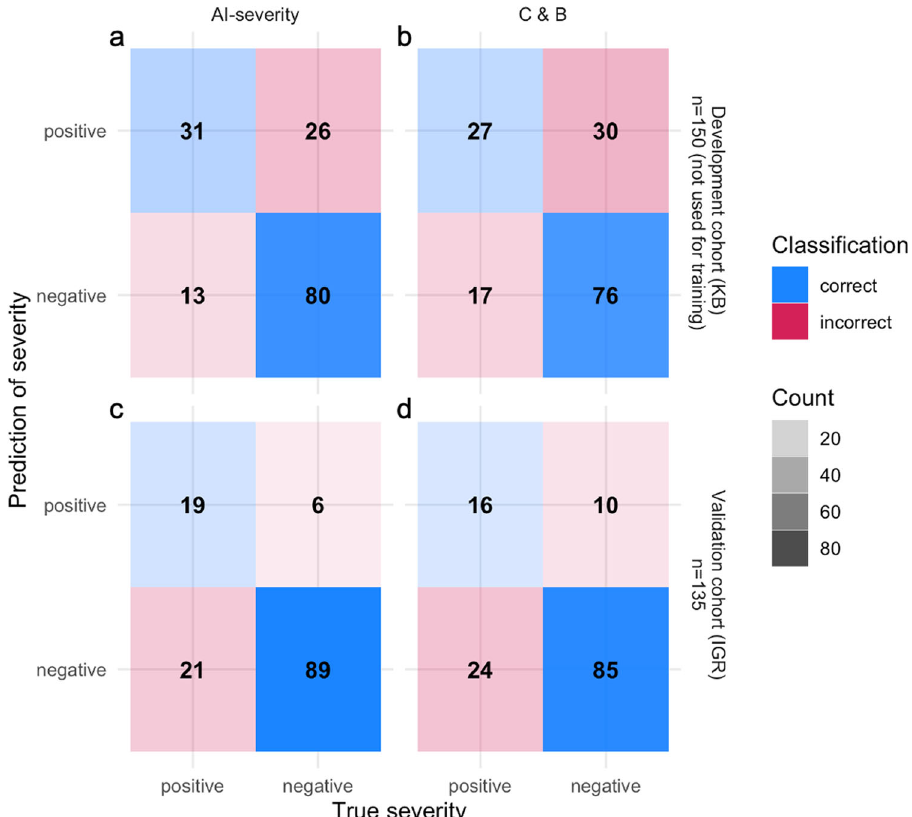
Fig. 3 Confusion matrix obtained with AI-severity, which includes CT scan information in addition to clinical and biological variables and with C & B, which contains only clinical and biological variables. Values in the matrices correspond to the number of patients in each category, which is de fi ned by the true severity status and its predicted one. The confusion matrix was computed using the outcome “ oxygen fl ow rate of 15 L/min or higher and/or the need for mechanical ventilation and/or patient death. ” For both scores, we considered the 2/3 quantile — computed using the development cohort (KB) — to distinguish severe patients from non-severe patients. In addition to the neural network variable computed from CT scan images, the variables included in AI-severity consist of oxygen saturation, age, sex, platelet, and urea. The variables included in C & B consist of oxygen saturation, age, sex, platelet, urea, LDH, hypertension, chronic kidney disease, dyspnea, and neutophil values. Both scores were constructed using a feature selection algorithm that selected optimal variables. KB Kremlin-Bicêtre hospital, IGR Institut Gustave Roussy